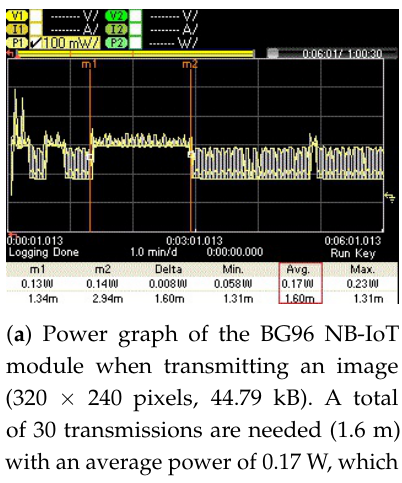
Figure 14. The energy consumed for transmitting an original image is ( a ) 0.0085 Wh and for trans- mitting its optimized version it is ( b ) 0.0015 Wh, i.e., 82.3% energy savings.